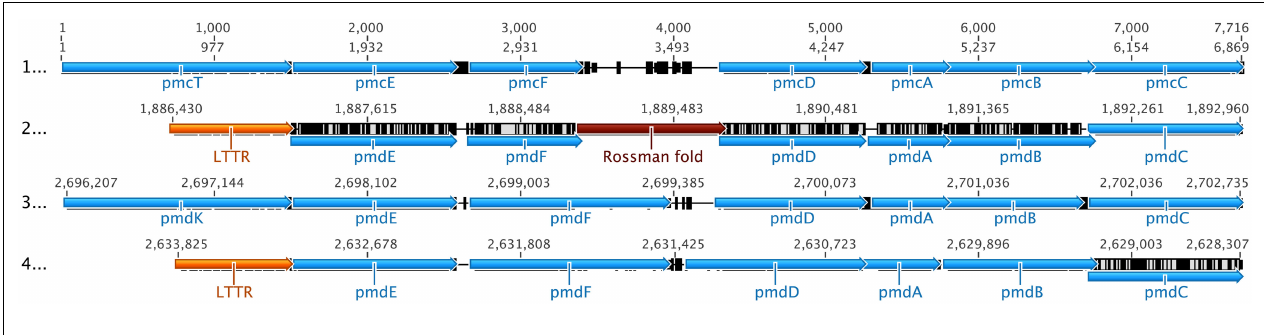
indicate position in the original source of that sequence. Colors indicate: pmd/pmc genes (light blue), genes for LTTR-Domain proteins (orange), genes for dehydrogenase-Rossmann fold-NAD(H) binding proteins (brown). Other genes including those encoding hypothetical proteins are black. Reactions catalyzed by pmd gene products are summarized in Figure 3 .